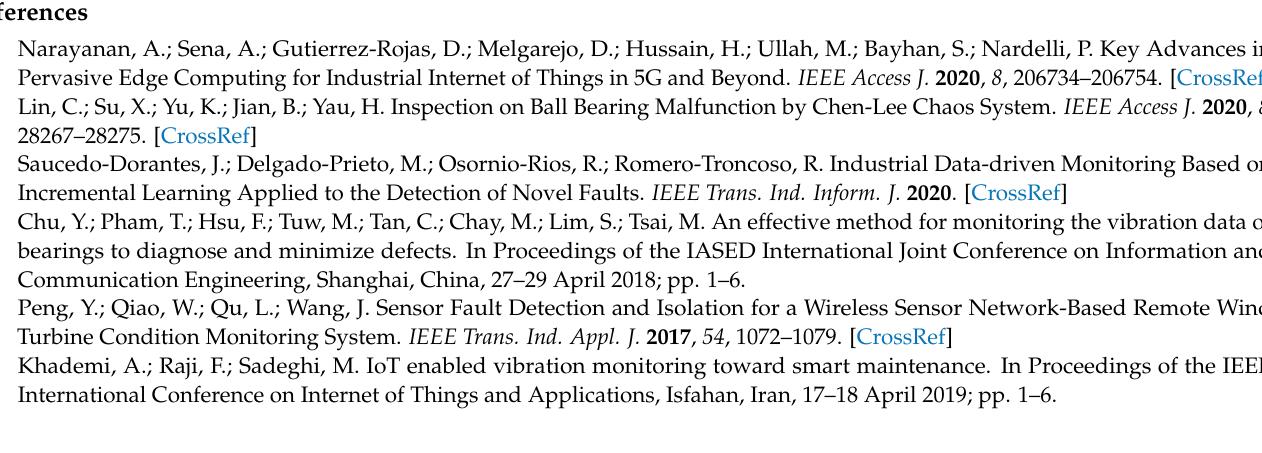
Figure 13. Prediction result of linear regression.